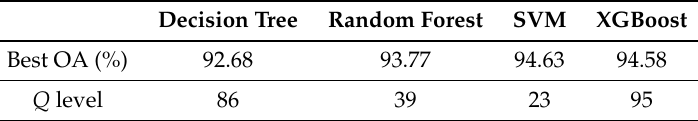
Table 5. Q levels with best OAs on data set B.